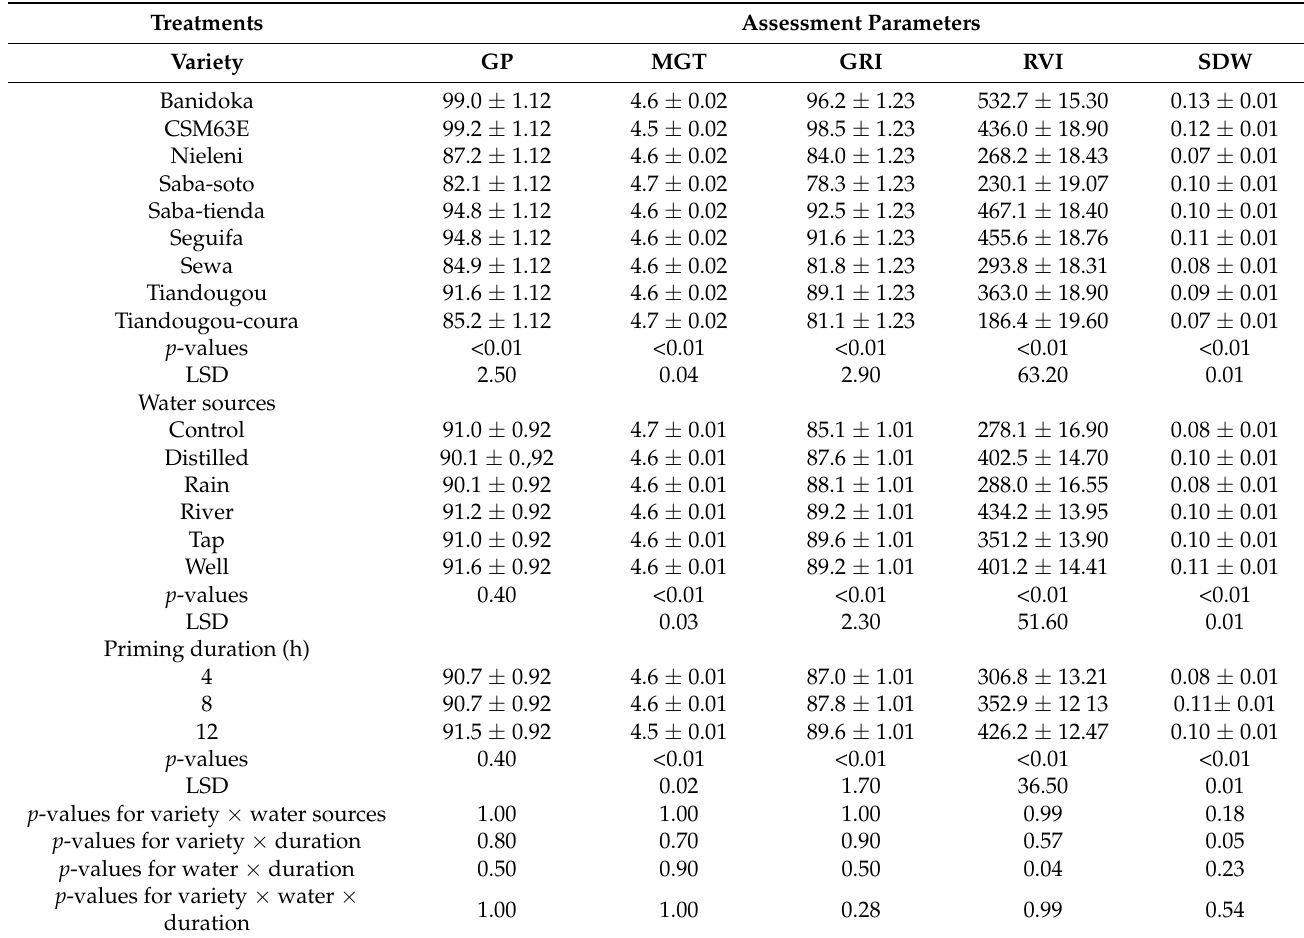
Table 5. Effect of tepid water priming at different durations and with water from different sources on seed germination and other growth parameters of nine varieties of